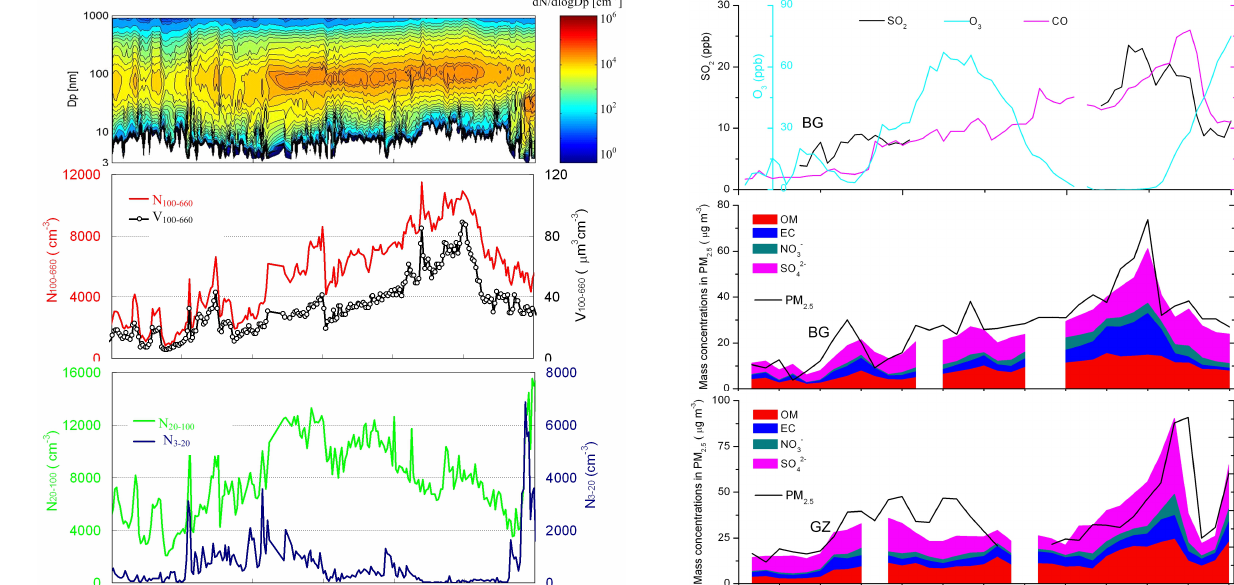
respectively (Table 3). If the average density of 100–660 nm particles is assumed to be 1.43 g cm − 3 as estimated in the summer of Beijing (Yue et al., 2009), the latter was equal to 5.7 µg m − 3 h − 1 . The increase rates of SO 2 − PM 2 . 5 were 2.4 and 0.6 µg m − 3 h − 1 , respectively. SO 2 −